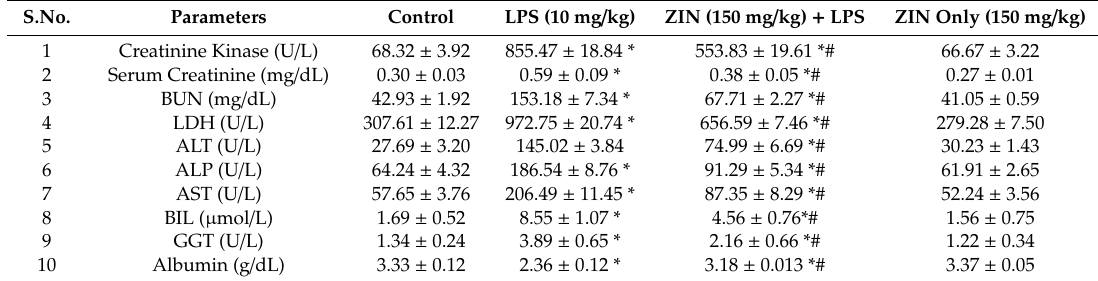
Table 1. List of plasma biochemical levels of di ff erent groups.